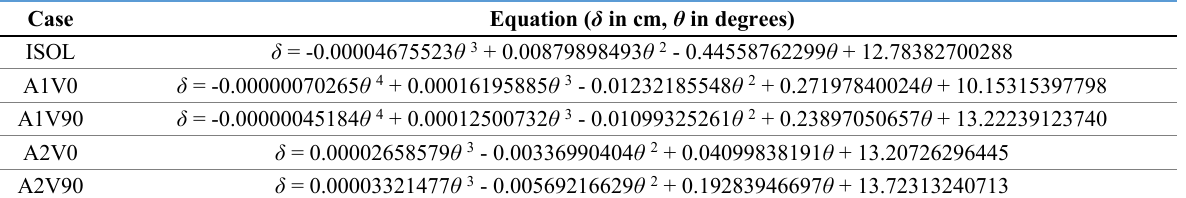
Table 9. Equations for maximum displacement at the top, y-direction.